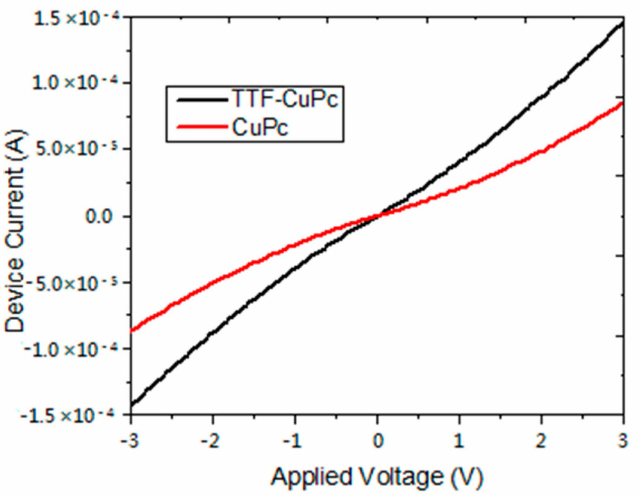
Figure 8. Current-voltage characteristics of CuPc